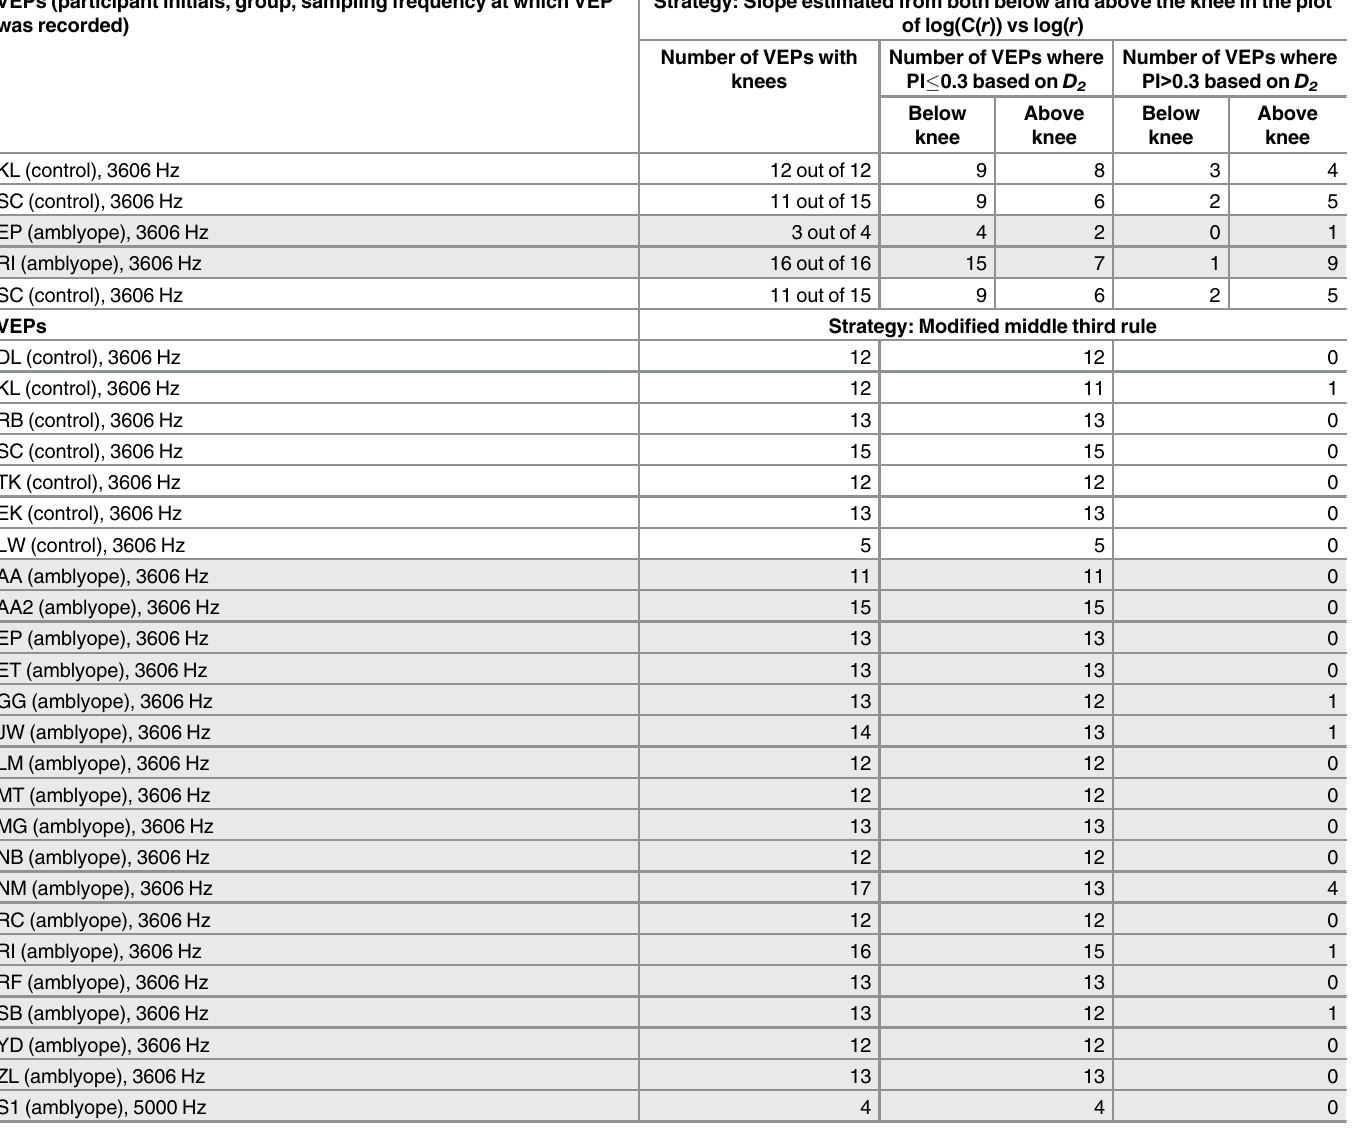
Table 2. Comparison of strategies for finding the scaling region. VEPs (participant initials, group, sampling frequency at which VEP was recorded)